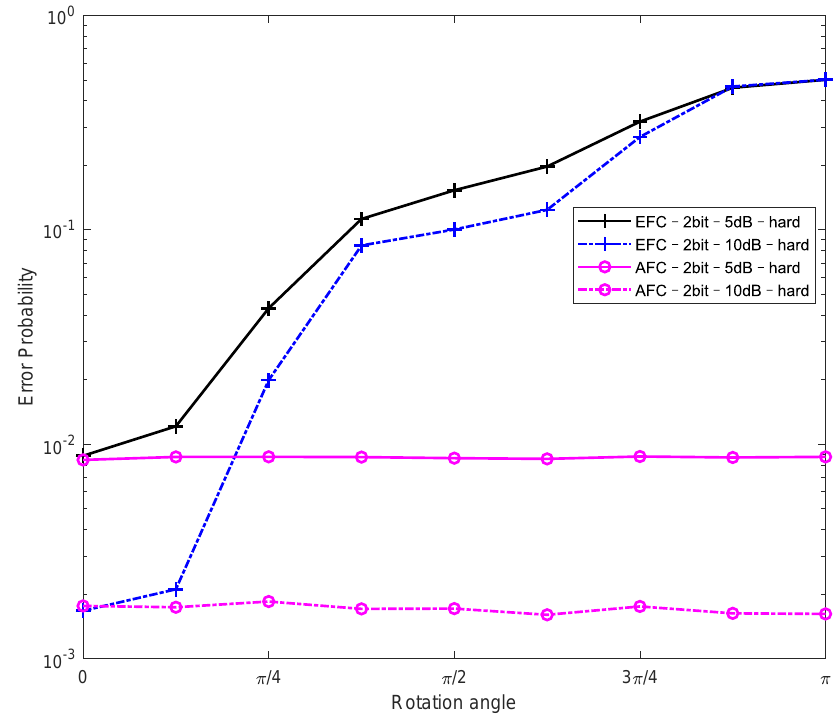
Figure 9. Error probabilities of the hard data fusion varying with φ for SNR = 5, 10 dB and snr L = 5